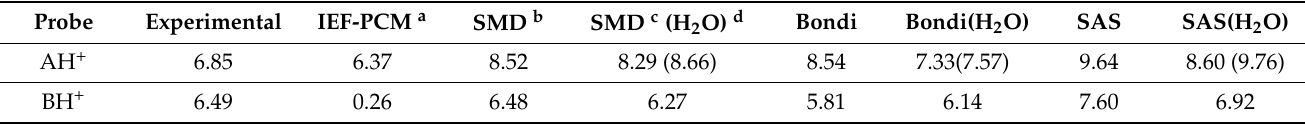
Figure 7. GaussView [30] drawings of the water molecule near the OH group for probes A , AH + , B, and BH + (left to right with the O probe ··· O water separation at 2.648, 2.659, 2.667 and 2.637 Å respectively). Table 2. Calculated p K a values for the probes.